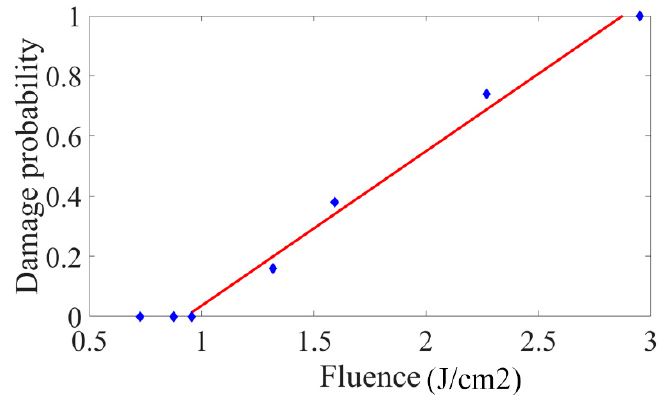
Figure 4. The results of the 1–on–1 tests.